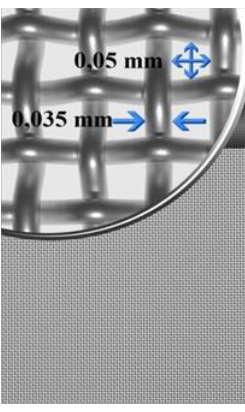
Figure 2. Mesh placed on the rotational viscometer’s rotor.